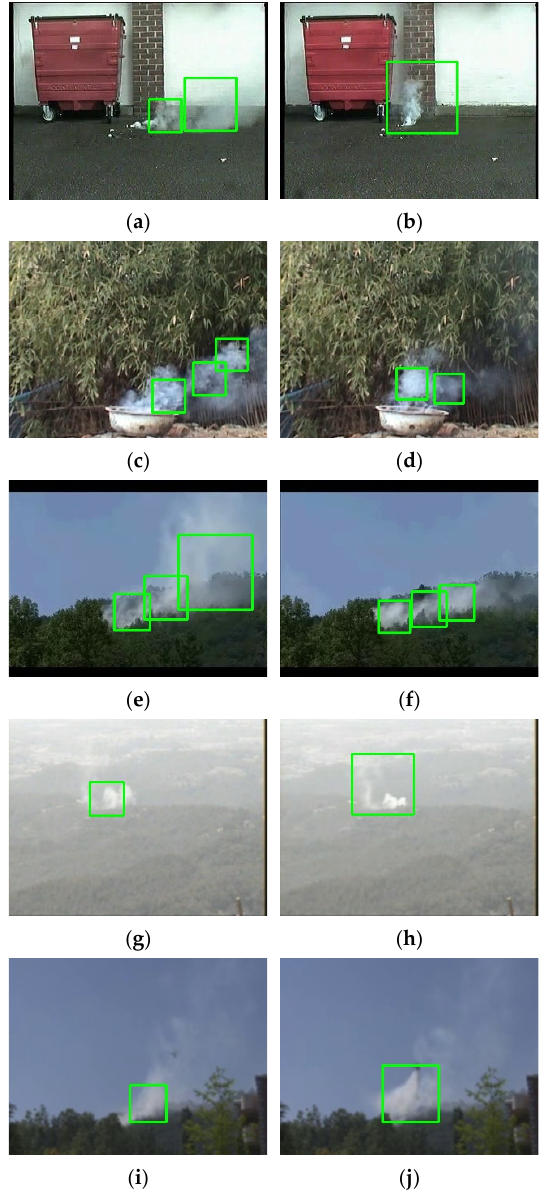
Figure 13. Example of detection effect where regions in green boxes are detected as smoke region: ( a ) 307th frame of test video 1 ( b ) 674th frame of test video 1 ( c ) 237th frame of test video 2 ( d ) 778th frame of test video 2 ( e ) 807th frame of test video 3 ( f ) 1414th frame of test video 3 ( g ) 454th frame of test video 7 ( h ) 584th frame of test video 7 ( i ) 698th frame of test video 8 ( j ) 770th frame of test video 8.